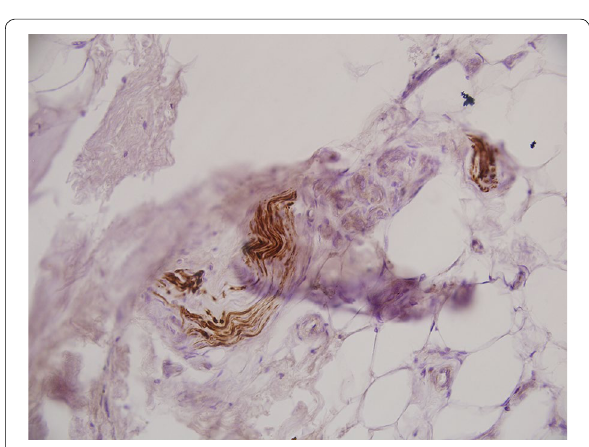
Fig. 2 Light microscopy (power 40 axons